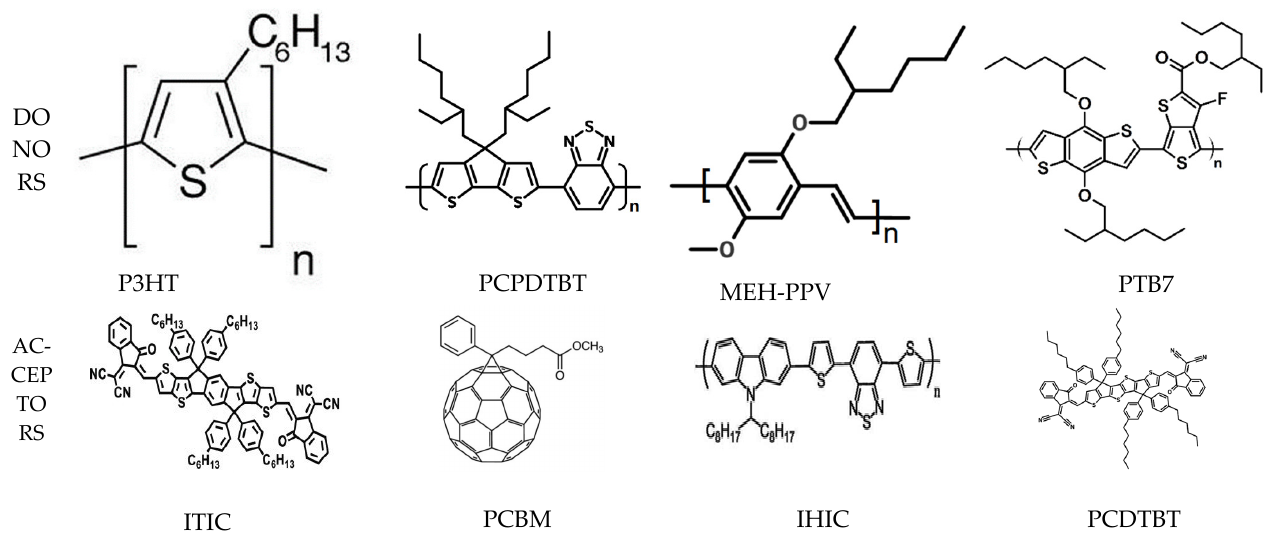
Figure 1. The structures of some important donor and acceptor materials of OSC.